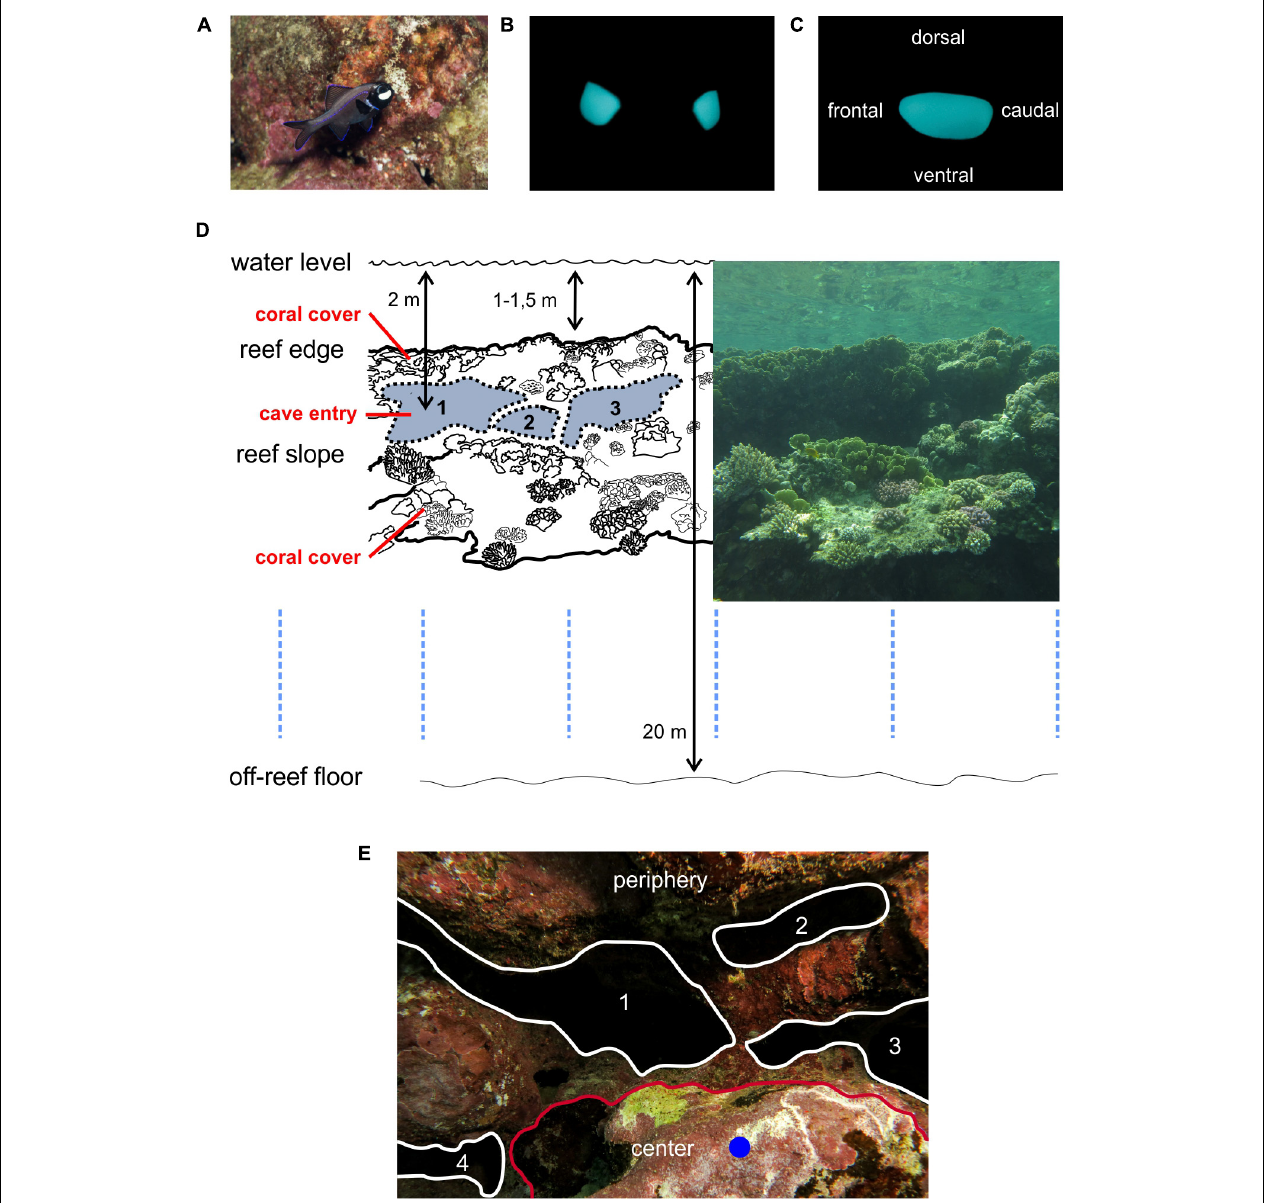
FIGURE 1 | Photoblepharon steinitzi in the Red Sea at the coast of Dahab. Bioluminescence of light organs and natural habitat of P. steinitzi . (A) Flash photograph of P. steinitzi in its natural habitat, a reef cave entrance area on a reef slope at the coast of the Red Sea. The bean shaped light organ appears as a white patch under the eye as a result of a mirror in the light organ and the reflection produced by the camera flash. The specimen showed an approximate length of about 10 cm. (B,C) Frontal and side views of P. steinitzi bean shaped light organs in the dark. The blue green bioluminescent light is produced by symbiotic luminescent bacteria in the light organs. (D) Example of one reef cave system in Dahab located in a shallow fringing reef at the Red Sea coast (N 28 ◦ 29.292 (cid:48) , E 034 ◦ 30.990 (cid:48) ). Photoblepharon steinitzi dwell after sunset in these small reef cave inlets at the reef slope. The scheme on the left represent a replica of the photograph on the right. Cave inlets on the reef slope are indicated by 1–3. Photographs were made with an underwater camera (Canon Powershot G15, 12 megapixel). (E) Example of one reef cave with. The red line indicates the border between the center where the dummies were placed and the peripgery. White lines indicate the entrance area of small branches in the reef cave system. The blue dot shows the dummy